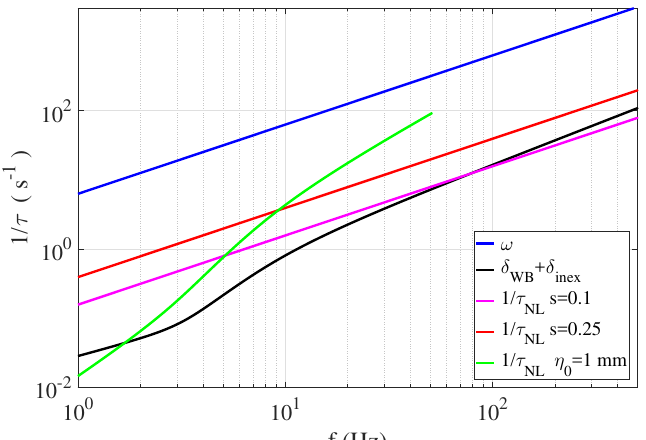
Figure 7. Comparison of different inverse characteristic times in the propagation of surface waves. Blue ω is the angular frequency of the wave. Black δ T = δ WB + δ inex is the total damping rate or the inverse of the dissipation time. Magenta 1/ τ NL is for a steepness s = 0.1. Red 1/ τ NL is for a steepness s = 0.25. Green 1/ τ NL is for a wave amplitude η 0 = 1mm (the curve is not displayed if the steepness exceeds 1). We observe that a significant level of nonlinearity is required for the nonlinear interactions to overcome the viscous dissipation. Consequently, the scale separation between 1/ τ NL and ω is